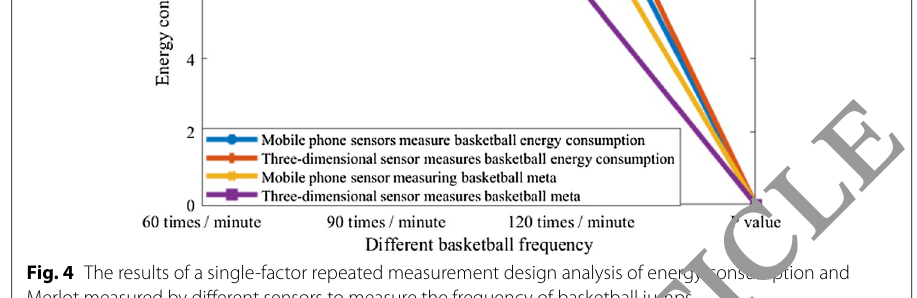
Fig. 4 The results of a single-factor repeated measurement design analysis of energy consumption and Merlot measured by different sensors to measure the frequency of basketball jumps